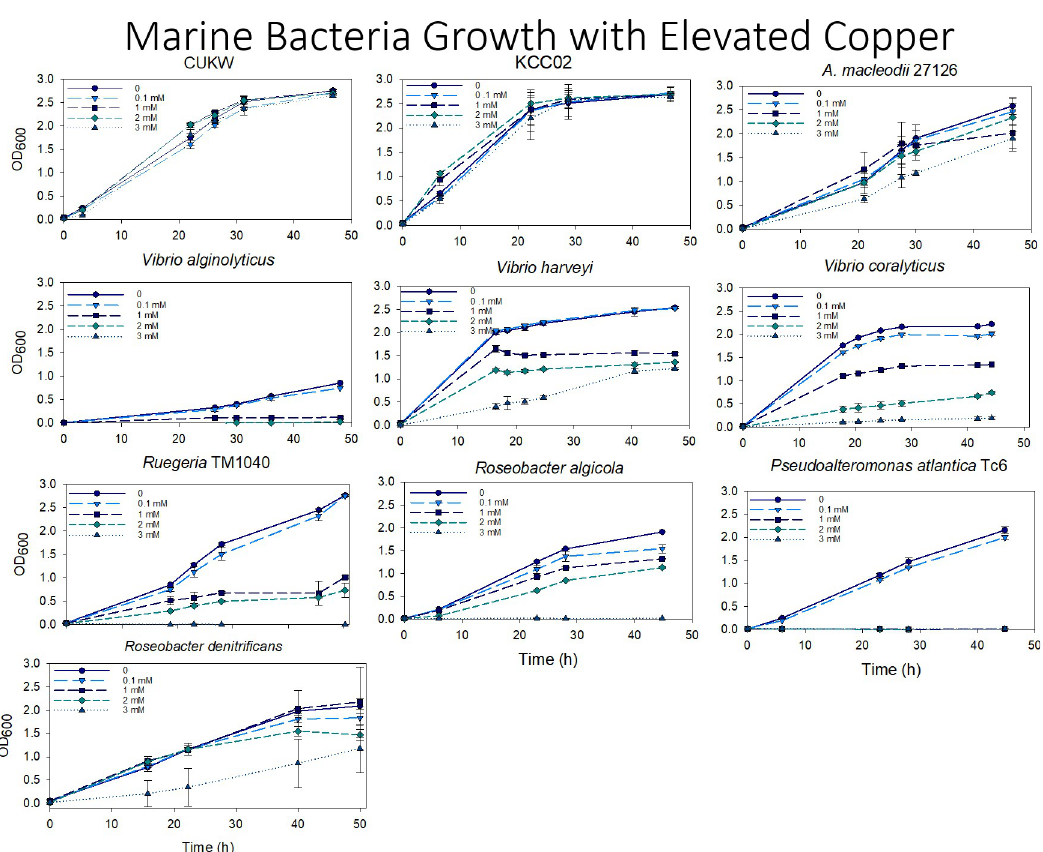
Fig 1. Marine bacteria copper resistance assays. Single colonies of marine bacterial species were inoculated into 3 ml of Burkholder’s B Formulation or Difco marine broth 2216 and grown overnight with agitation. Upon reaching late exponential phase, cultures were inoculated at a 1:100 dilution into 10 ml of fresh medium and copper added to final concentrations of 3 mM, 1 mM, 2 mM, or 100 μ M. Cultures were incubated with agitation for ca. 48 h and growth recorded as the change in optical density at 600 nm over time. Error bars represent standard deviation of two biological replicates, with three technical replicates recorded for each.